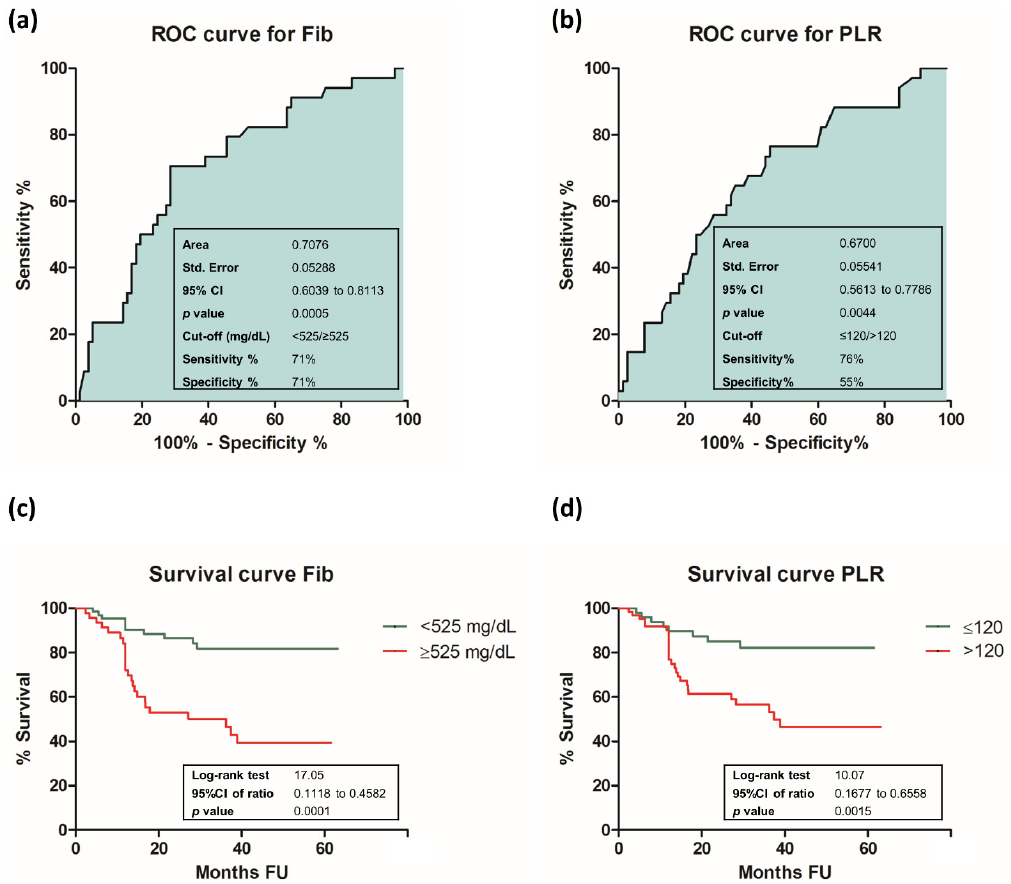
Figure 1. ROC and Survival curves for Fib and PLR: ( a ) ROC curve for Fib; ( b ) ROC curve for PLR; ( c ) survival curve for Fib; ( d ) survival curve for PLR. Statistical significance was considered at p < 0.05.